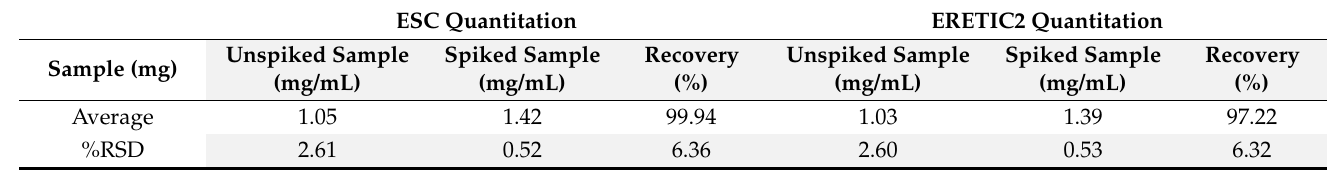
Figure 5. Overlapped 1 H-NMR spectra (400 MHz, DMSO- d 6 ) of T. diffusa standardized extract (red line) and T. diffusa standardized extract spiked with 250 µ L of 2.5 mM hepatodamianol (blue line). The expansion shows the region of the observed hepatodamianol:CH 3 -6 (cid:48)(cid:48)(cid:48) resonance at 0.515 ppm. Table 6 . Hepatodamianol recovery results ( n = 3) obtained by ESC and ERETIC2 (based on the PULCON method).